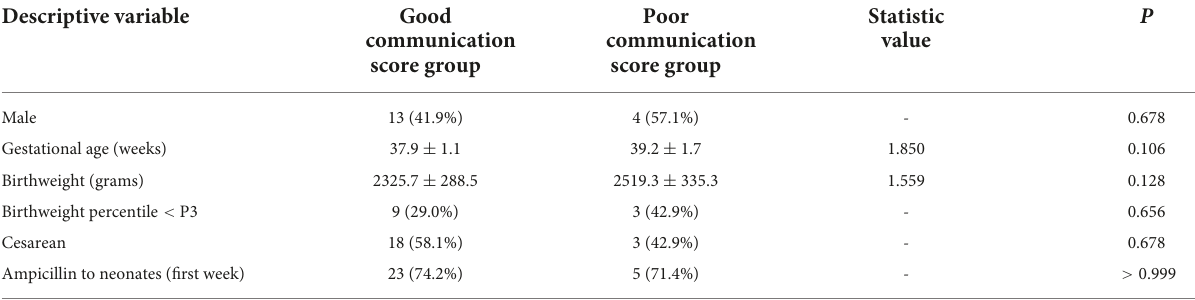
TABLE 4 Clinical characteristics of the good and poor communication score groups in the SGA population. Descriptive